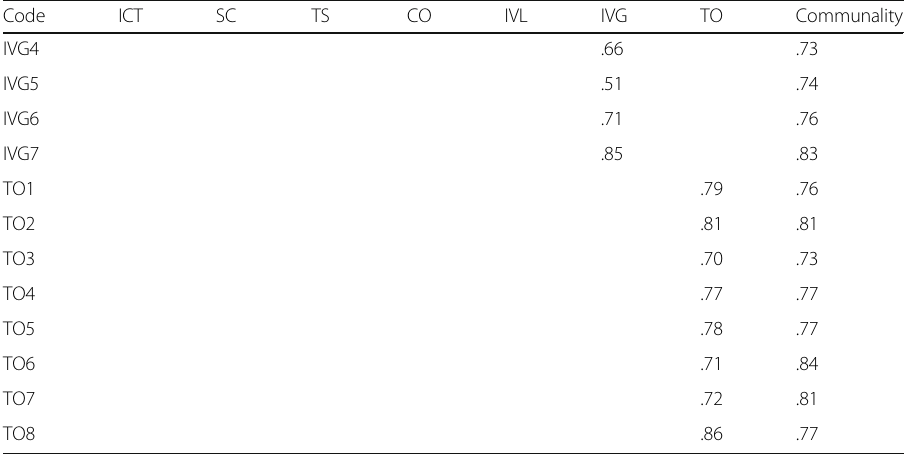
Table 6 Factor loadings and communalities for 55 items measuring ICT-supported learning environment perceptions ( N = 90)